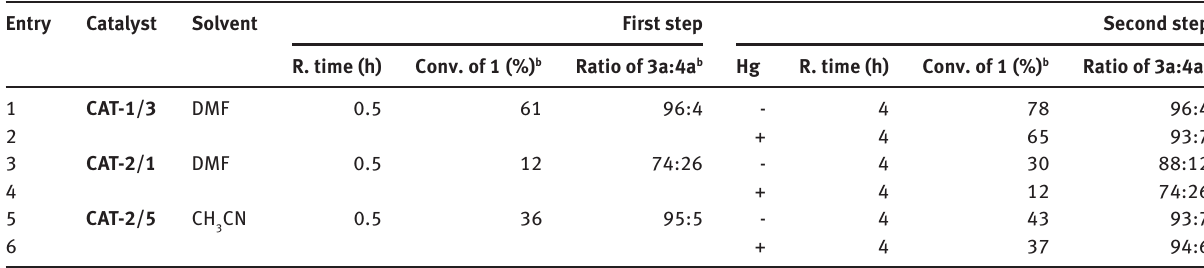
Table 4: Hot filtration and mercury poisoning tests a